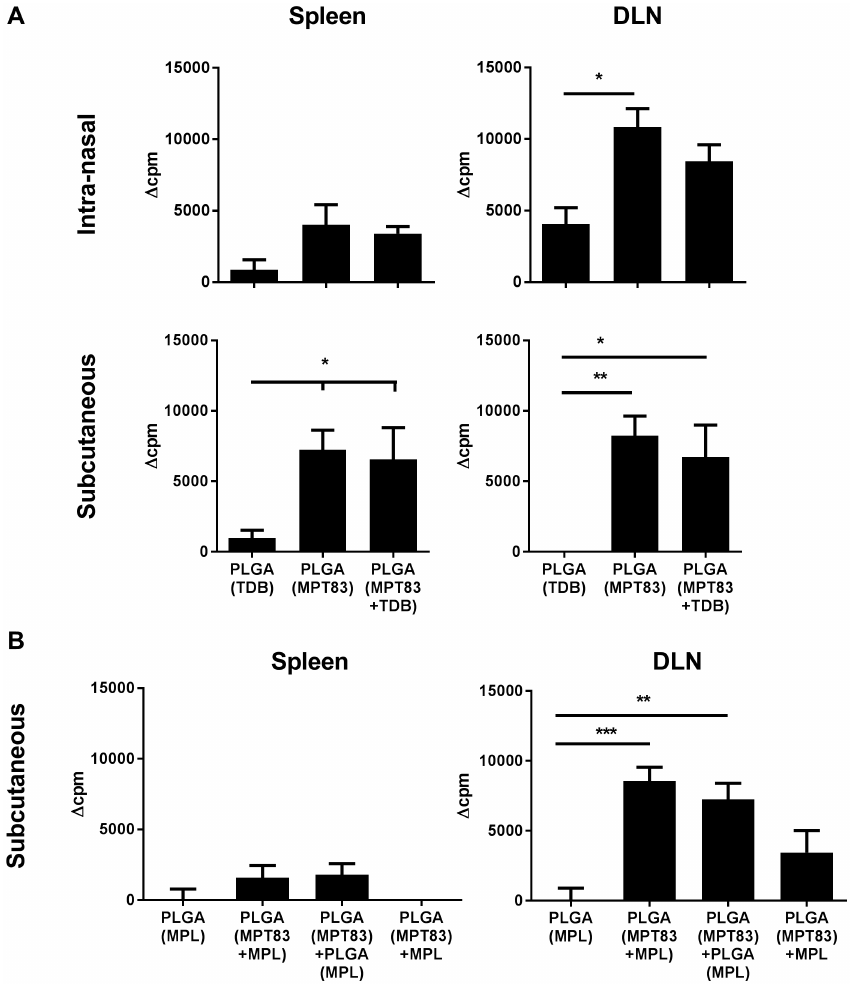
Fig 4. Systemic proliferative antigen-specific lymphocytes were induced following vaccination with PLGA particulate vaccines. C57BL/6 mice were immunised three times at two-weekly intervals with 1 mg PLGA vaccine, either i.n or s.c as indicated, adjuvanted with (A) TDB or (B) MPL. Leukocytes from the spleens and LN of vaccinated mice were stimulated with MPT83 (10 μ g/ml) ex vivo four weeks after last vaccination. Proliferation of antigen-specific cells was determined by 3 H-thymidine incorporation assay, measured by delta counts per minute ( Δ cpm; test minus the mean of negative/adjuvant only control) for immunised mice. The data are the means ± SEM (n = 3). Statistical significance was calculated by ANOVA with Bonferroni post-hoc comparison to adjuvant only control ( (cid:3) p < 0.05, (cid:3)(cid:3) p < 0.01, (cid:3)(cid:3)(cid:3) p < 0.001).